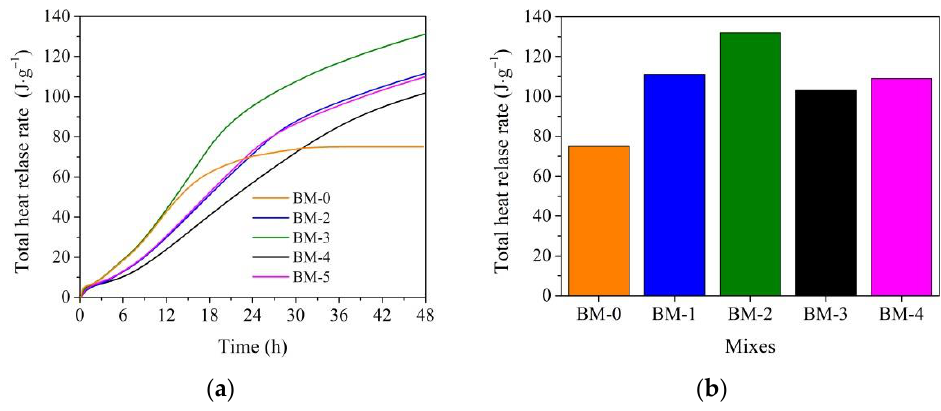
Figure 6. The total heat release rate for BM-0 – BM-4 mixes: ( a ) curves; ( b ) maximum values.